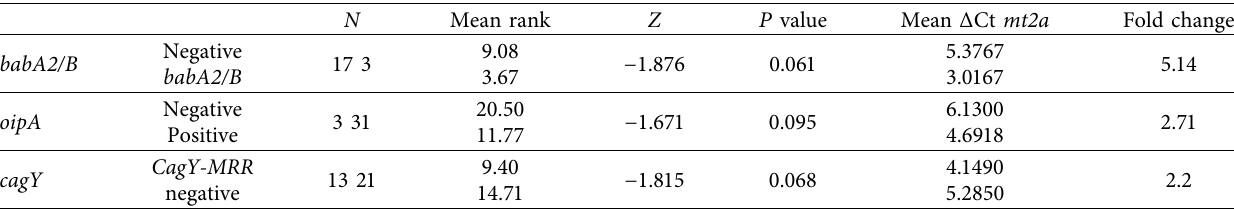
Table 9: The statistical results of mt2a gene expression with H. pylori infection and its virulence genes expression using Mann–Whitney